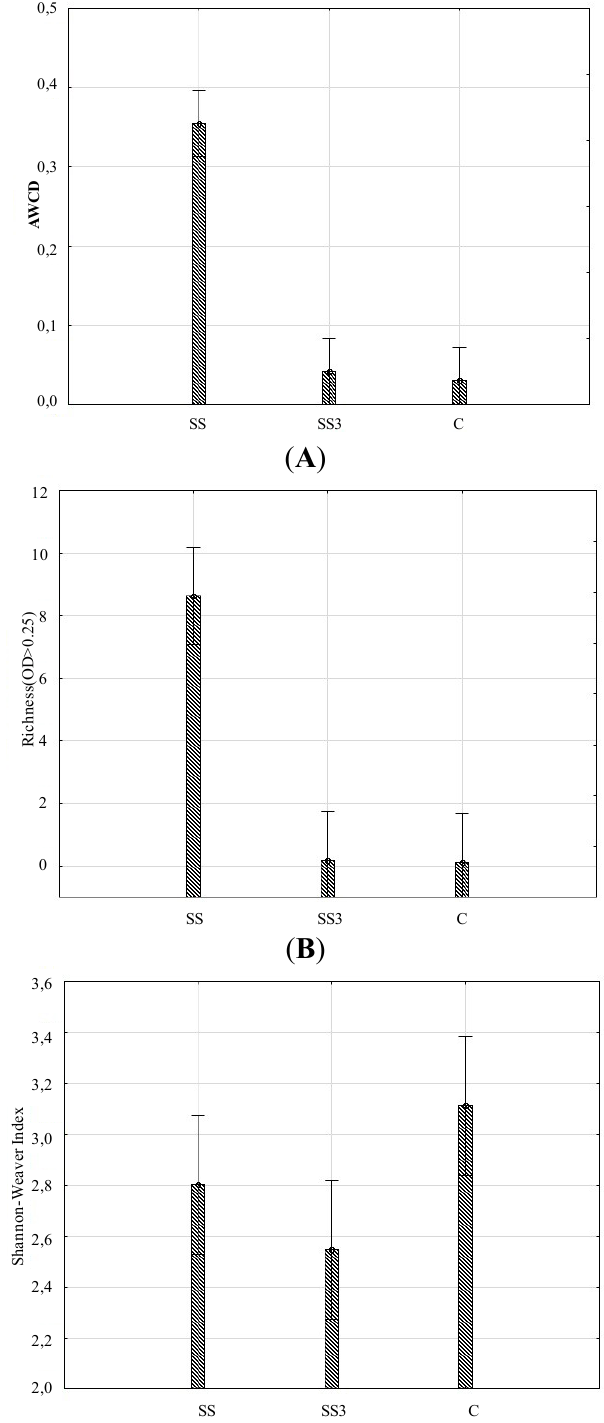
10 and 8000%. The AWCD and R were significantly greater for the SS when compared with the SS3 and C (Figure 2B). Figure 2. Average well-color development (AWCD) ( A ), Richness ( B ) and the Shannon-Weaver index ( C ) of the metabolized substrates in the Biolog EcoPlate in the soil. SS—soil under sewage sludge accumulation, SS3—soil 3 meters from the sewage sludge landfill, and C—control soil 200 meters from the sewage sludge